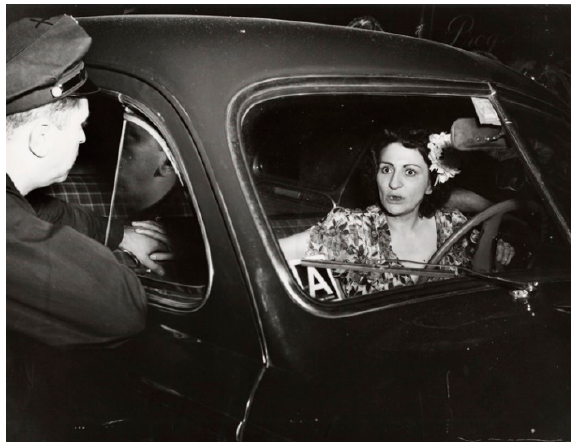
Figure 4. Weegee, [Police officer talking to Dorothy Reportella after she crashed into a truck, New York], 7 September 1944. © Weegee/International Center of Photography